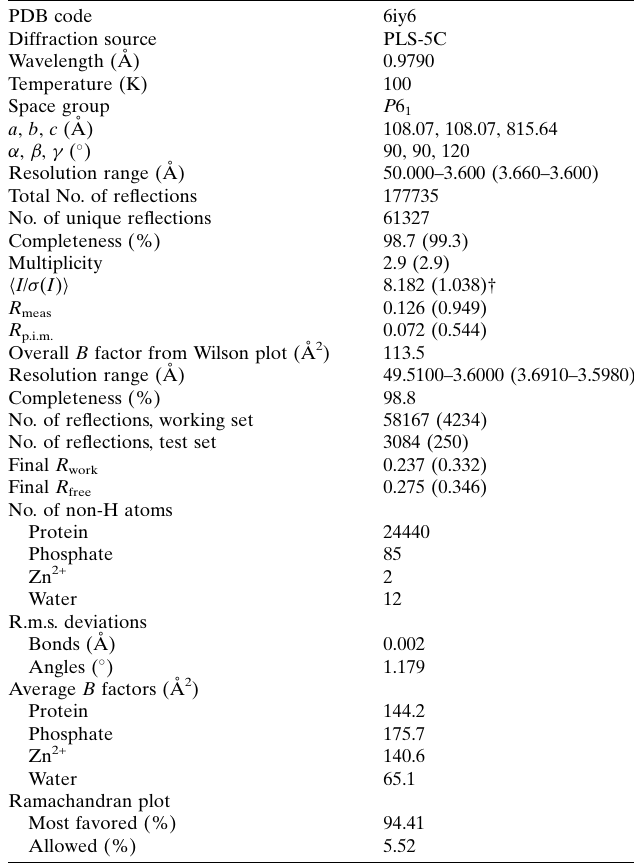
Table 1 Data-collection and refinement statistics. Values in parentheses are for the highest resolution